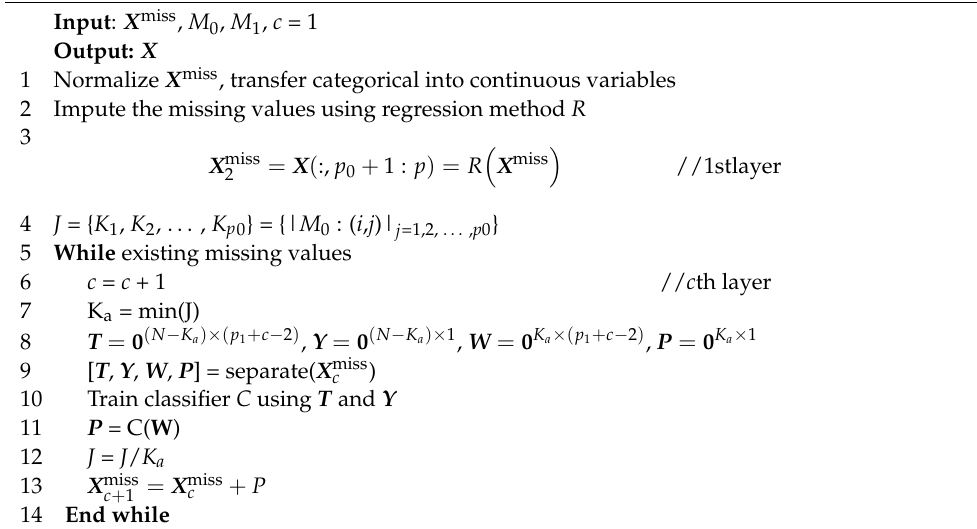
Algorithm 1. Prediction workflow of the proposed